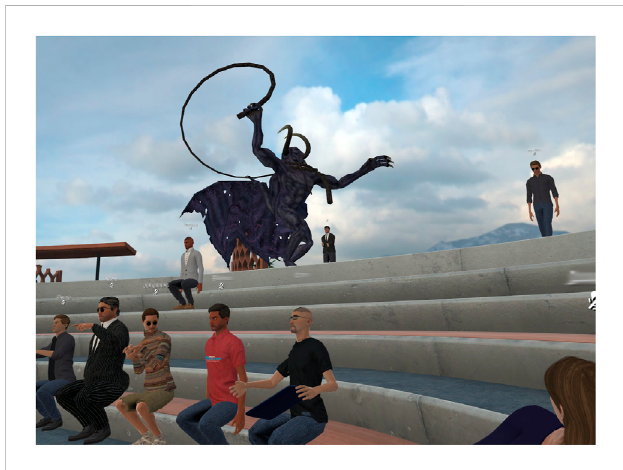
FIGURE 9 A user inserted a daemon to the scene whipping a colleague ’ s avatar in the middle of a student ’ s